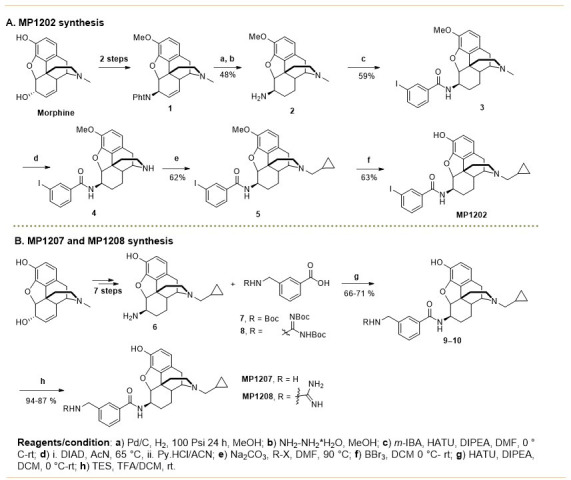
Synthesis of m-arylamido dihydromorphinans MP1202 (A), MP1207, MP1208 (B).